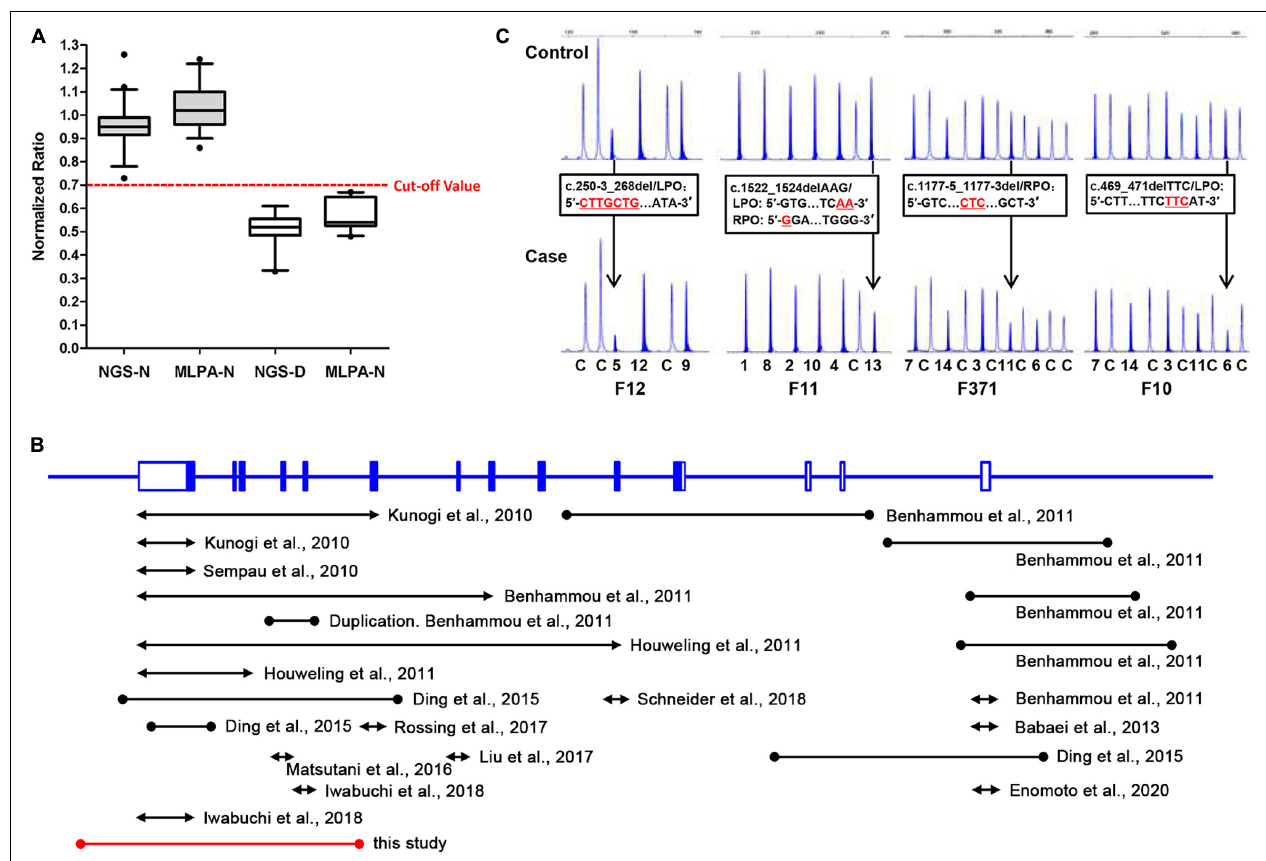
FIGURE 3 | A comparative analysis of NGS and MLPA and a review of previously reported FLCN intragenic deletions. (A) Box-plot (median, box: 5–95th percentile, whiskers) representation of haploid copy number values for FLCN deleted exons (NGS-D and MLPA-D) and normal controls (NGS-N and MLPA-N) by NGS and MLPA, respectively. The red dotted line represents the cut-off value; exons with values < 0.7 were scored as deleted, while > 0.7 as normal status. (B) Genomic structure of the FLCN gene, showing the locations and sizes of previously reported large intragenic deletions found in BHD patients; black line: deletions previously reported. Red line: deletion found in this study. The lines with solid circles or arrowheads at both ends indicate the deletions with breakpoints determined or undetermined, respectively. (C) Small indels can show peak heights of heterozygous exonic deletions (normalized ratio < 0.7) compared with the control individuals (black arrow) in MLPA analysis. DNA changes/ FLCN probe sequences are presented in black frames, respectively. LPO (Left Probe Oligo) is the 5 (cid:48) half of the probe; RPO (Right Probe Oligo) is the 3 (cid:48) half of the probe. Red underlined characters indicate deleted bases. The characters and numbers below the probes indicate exons and control probes. The number below each MLPA result indicate sample number in our private sample